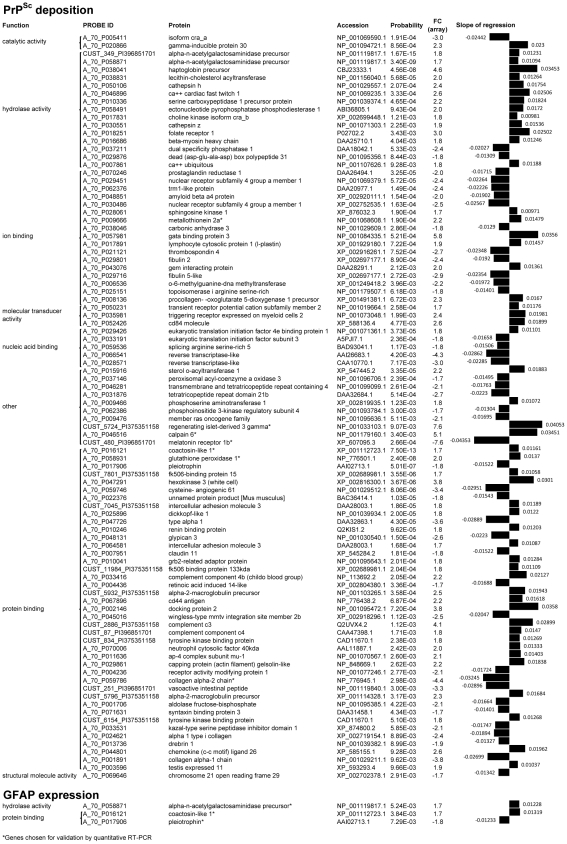
Relationship between gene expression profiles and scrapie histopathological lesions.A selection of genes whose expression was significantly related to PrPsc deposition and glial fibrillary acidic protein expression grouped by their function is shown. Probe ID, accession numbers of proteins encoded by these genes and probability of the slope of regression between histopathological lesions and gene expression obtained using a Mixed Model approach are shown.